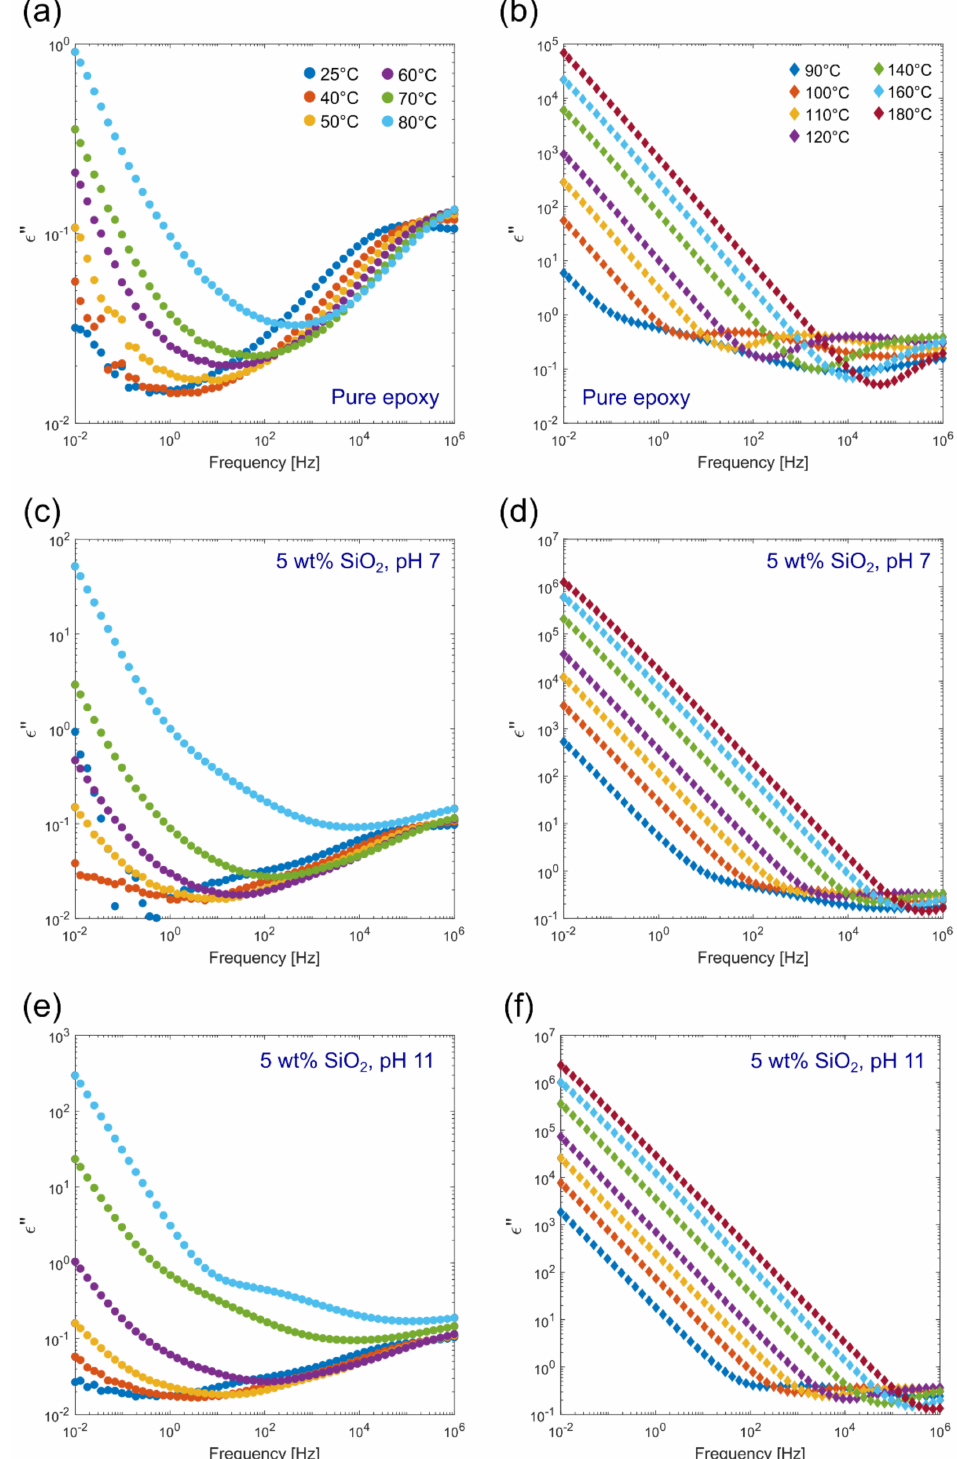
Figure 10. The imaginary permittivities ( ε ”) for ( a , b ) pure epoxy, and epoxy nanocomposites prepared with 5 wt.% SiO 2 at ( c , d ) pH 7, and ( e , f ) pH 11. The plots on the left ( a , c , e ) show the permittivities below 80 ◦ C, while the plots on the right ( b , d , f ) show the permittivities above 80 ◦